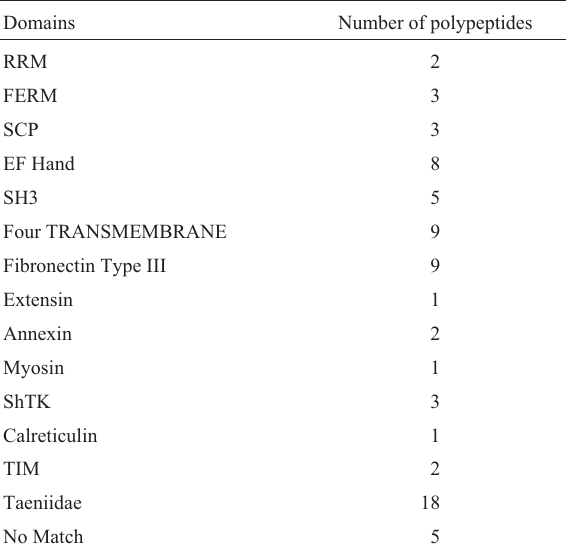
Table 3 - Domains and corresponding